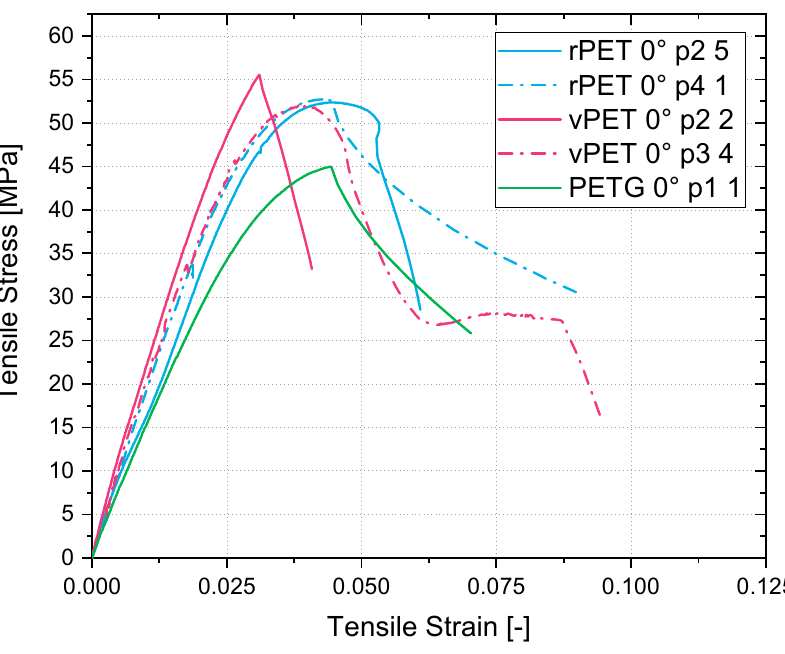
Figure 14. Stress–strain diagram at 0 ° bead orientation.